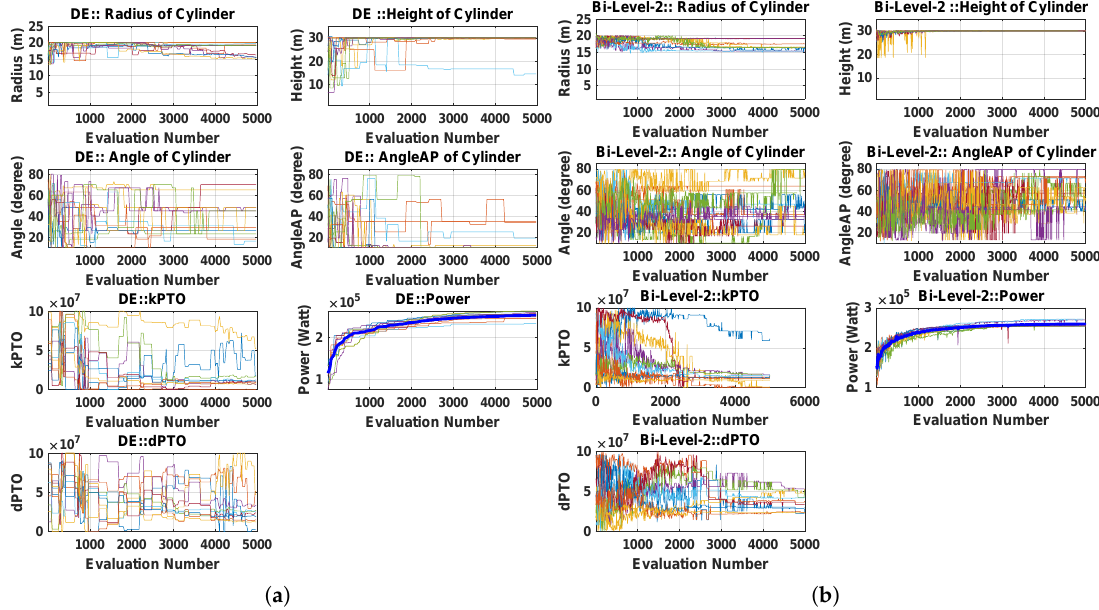
Figure 11. Search history and trajectory of the best solution per each population in all decision variables. ( a ) the optimisation process (power maximisation) of DE, ( b )